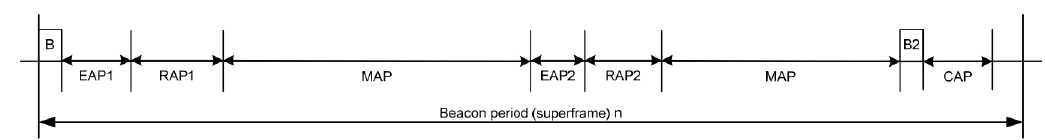
Figure 15. Beacon based IEEE 802.15.6 superframe